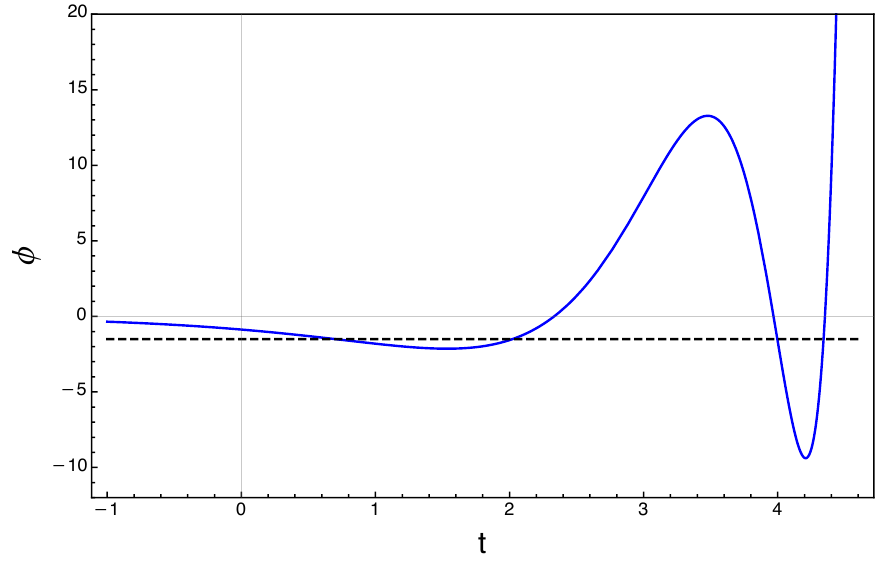
Figure 1 . The rolling solution in nonlocal theory with ξ = 0 . 39 , keeping terms up to n = 30 . The turning point at φ = − 3 / 2 is marked with black dashed line. Similar to the rolling solutions in [27], this also overshoots the turning points and oscillations get larger with